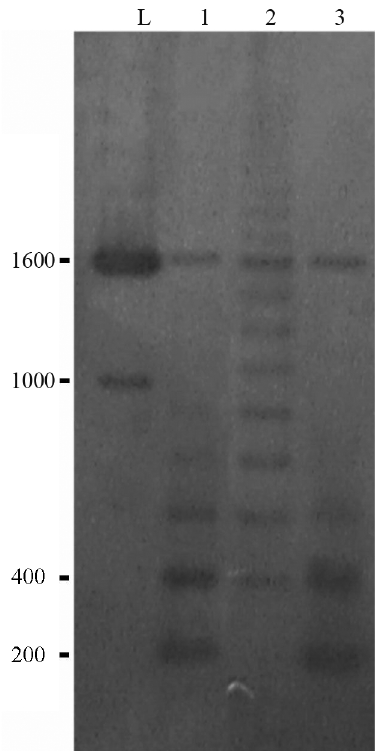
Figure 2 - Southern blot hybridization of Hind III-digested genomic DNA of Steindachnerina insculpta (1) and Cyphocharax modesta (2 and 3), us- inga5SrDNAmonomerasaprobe.DNAwasdigestedfor10minin1and 2 and overnight in 3. Molecular weight markers (bp) are indicated on the